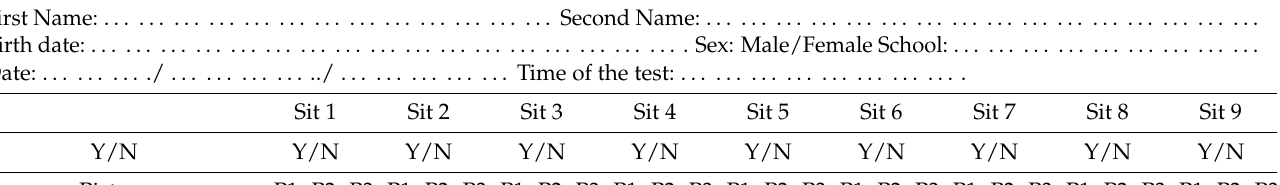
Table A1. Encoding grid for the face validity.